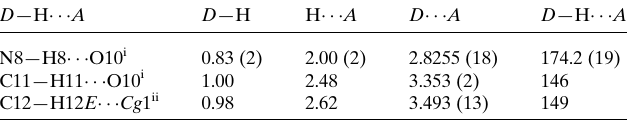
Table 3 Hydrogen-bond geometry (A˚ , (cid:2) ) for 1b . Cg 1 is the centroid of the C1–C6 ring.